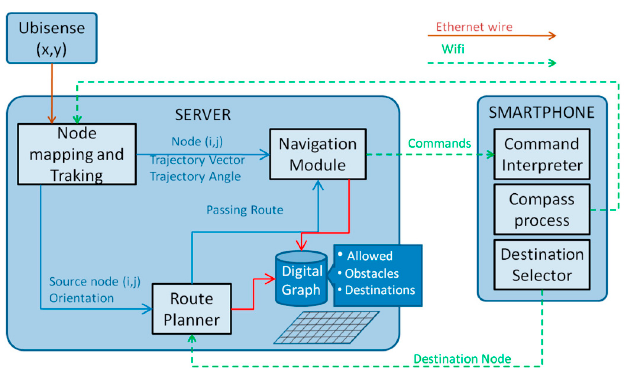
Figure 40. The system’s installation inside a room [61].